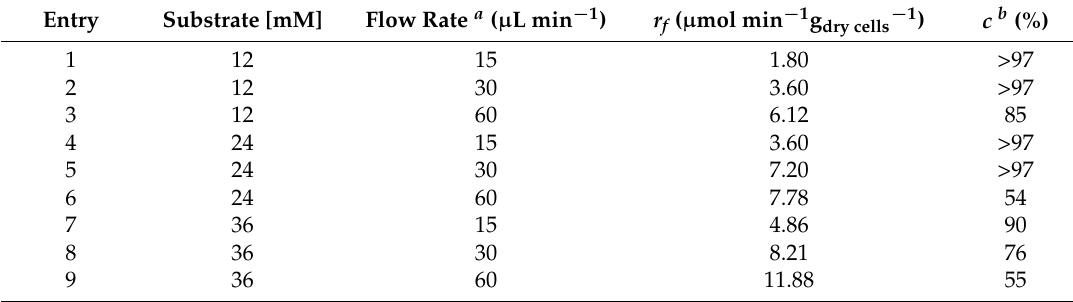
Table 1. Continuous flow enantioselective oxidation of 1a with immobilized Acetobacter aceti MIM